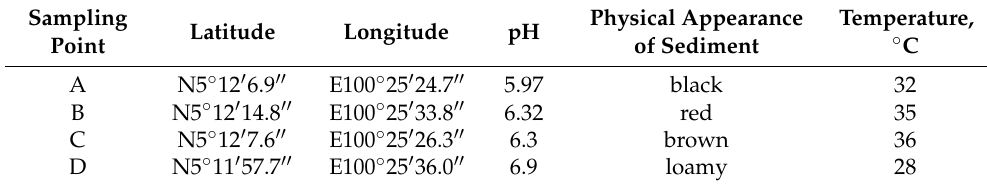
Table 2. Sampling location and condition of sediment samples collected from the Pulau Burung